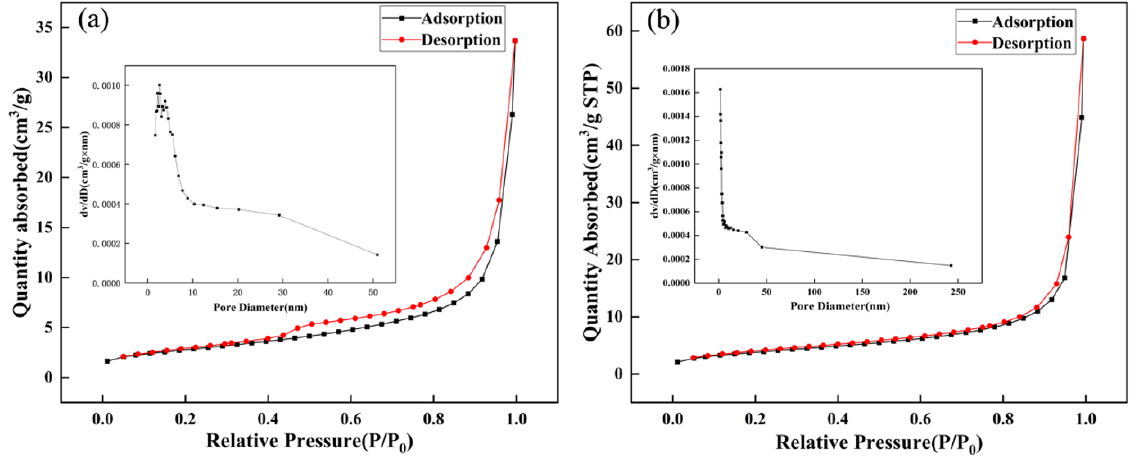
Figure 5. Nitrogen adsorption–desorption isotherms of ZnSnO 3 ( a ) and Bi-ZnSnO 3 (4 wt%) compo- sites ( b ); the inset is the BJH pore size distribution